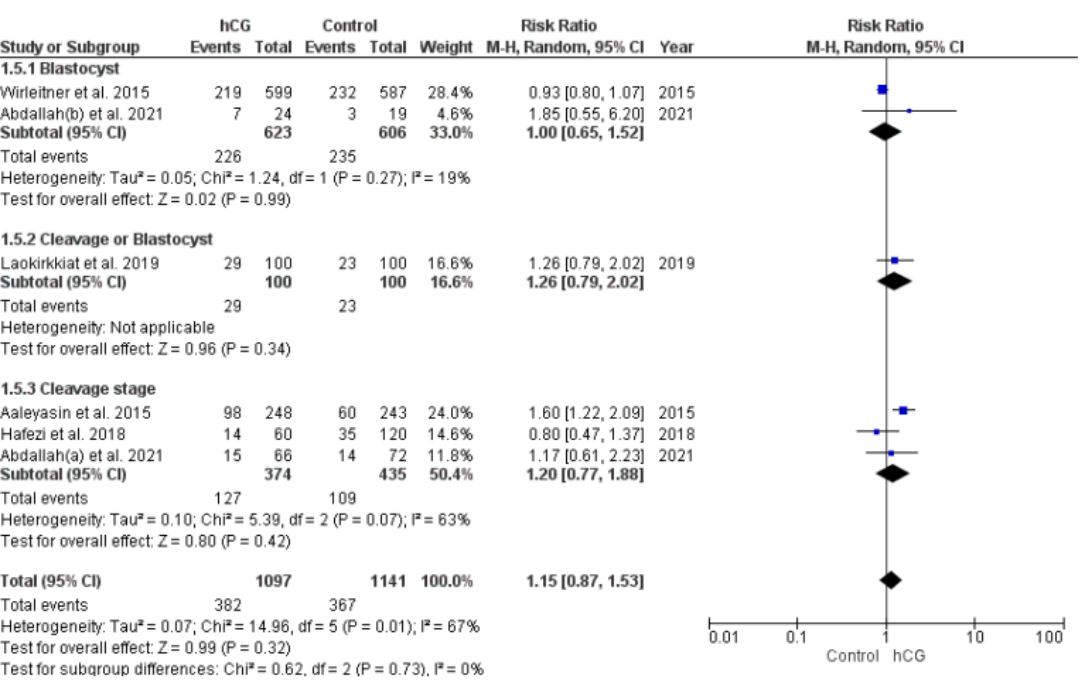
Figure 5. Forest plot showing the effect of intrauterine hCG injection versus control group on live birth rate.